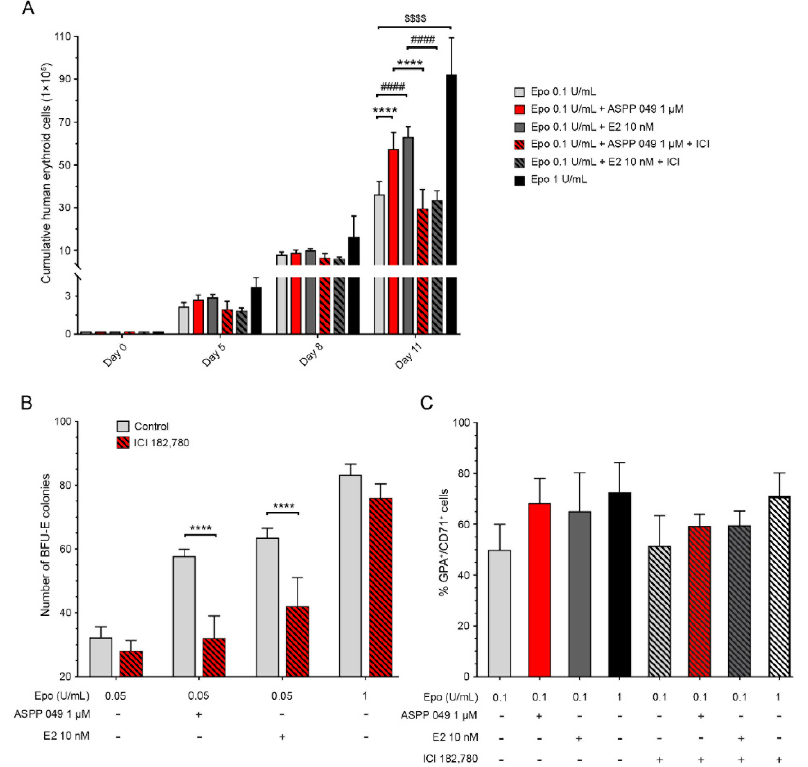
Figure 4. Induction of erythropoiesis by ASPP 049 and E2 requires estrogen receptors. ( A ) As indicated, CD34 + HSCs plated in a human erythroid culture medium were treated with 1 μ M ASPP 049 and 10 nM E2 in the presence of 0.1 U/mL Epo or 1 μ M ICI 182,780 (an estrogen receptor antagonist) for 5, 8, or 11 days; 1 U/mL Epo was used as a positive control. Survival of human erythroid ‐ derived HSCs was observed by trypan blue exclusion assay. ( B ) As indicated, CD34 + HSCs plated in MethoCult H4236 were treated with 1 μ M ASPP 049 and 10 nM E2 in the presence of 0.05 U/mL Epo or 1 μ M ICI 182,780; 1 U/mL Epo was used as a positive control. Numbers of BFU ‐ Es were scored on day 14 according to the manufacturer’s recommendations. ( C ) CD34 + HSCs were plated in human erythroid culture medium and treated with 1 μ M ASPP 049 and 10 nM E2 in the presence of 0.1 U/mL of Epo or 1 μ M ICI 182,780, as indicated. Expression of immature erythrocyte markers (GPA + CD71 + ) was detected by flow cytometry analysis. All data are expressed as mean ± SEM ( n = 3). **** p < 0.0001, ASPP 049 compared with vehicle control treatments (ANOVA); #### p < 0.0001, E2 compared with vehicle treatments (ANOVA); $$$$ p < 0.001, 1 U/mL compared with vehicle control treatments (ANOVA). BFU ‐ Es, burst ‐ forming unit ‐ erythroid cells; E2, 17 β‐ estradiol; Epo, erythro ‐ poietin; HSCs, hematopoietic stem cells.